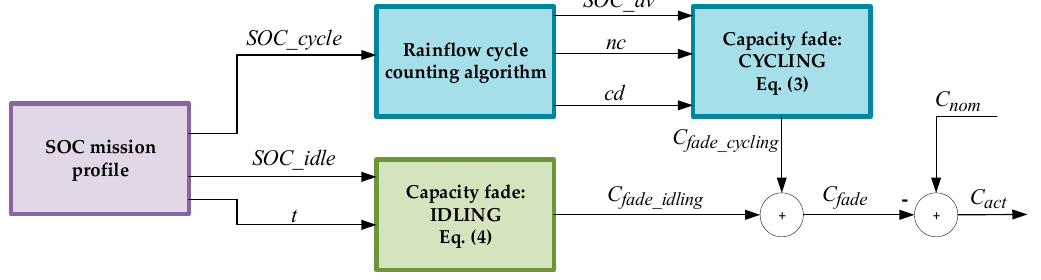
Figure 5. Developed lifetime model of the BESS unit.